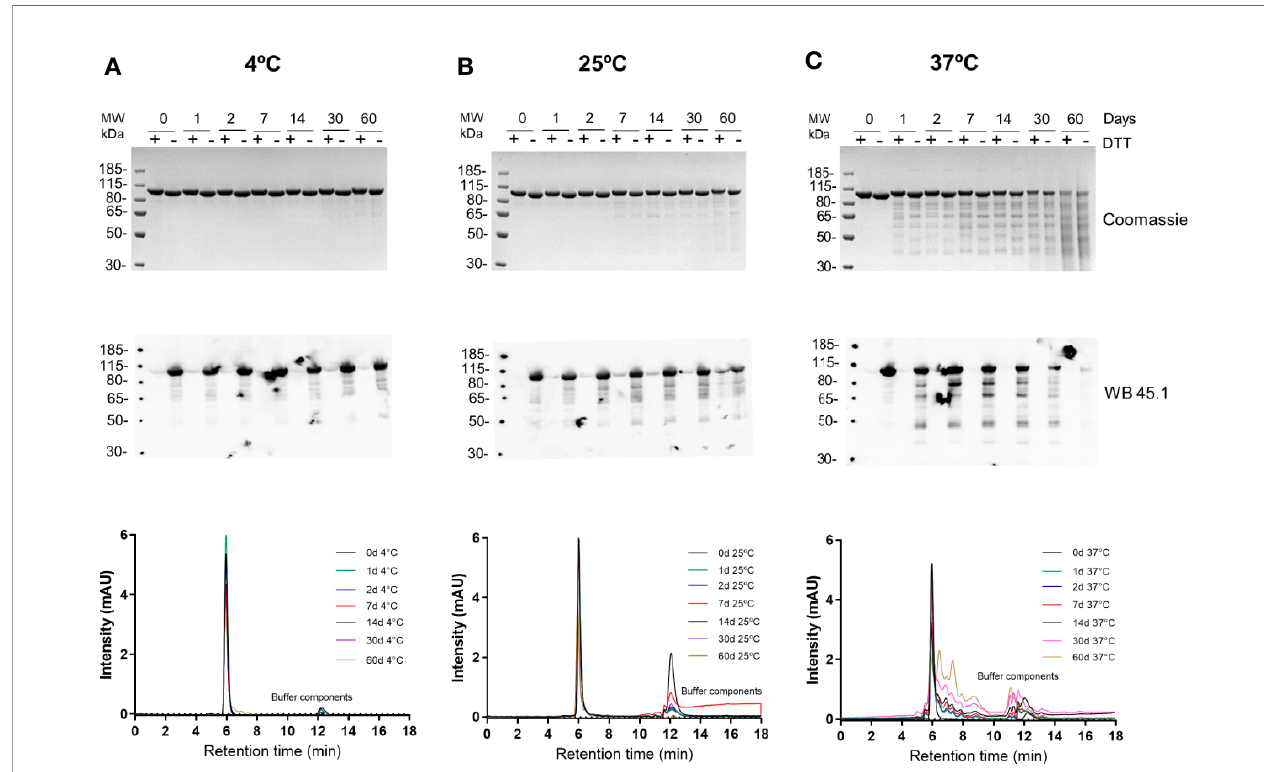
FIGURE 5 | Stability analysis of R0.6C. Short term stability at (A) 4°C, (B) 25°C, and (C) 37°C; Coomassie blue-stained 4% – 12.5% polyacrylamide gel; Numeric zero,1,2, 7,14, 30, and 60 corresponds to days at different temperatures( upper panel) ;immune blot analysis of the same gels with mAb45.1 and size-exclusion chromatography (SEC) analysis (overlap chromatograms) of samples used ( middle and lower panel respectively). Representative SEC chromatograms of R0.6C protein eluted contains the majority of the